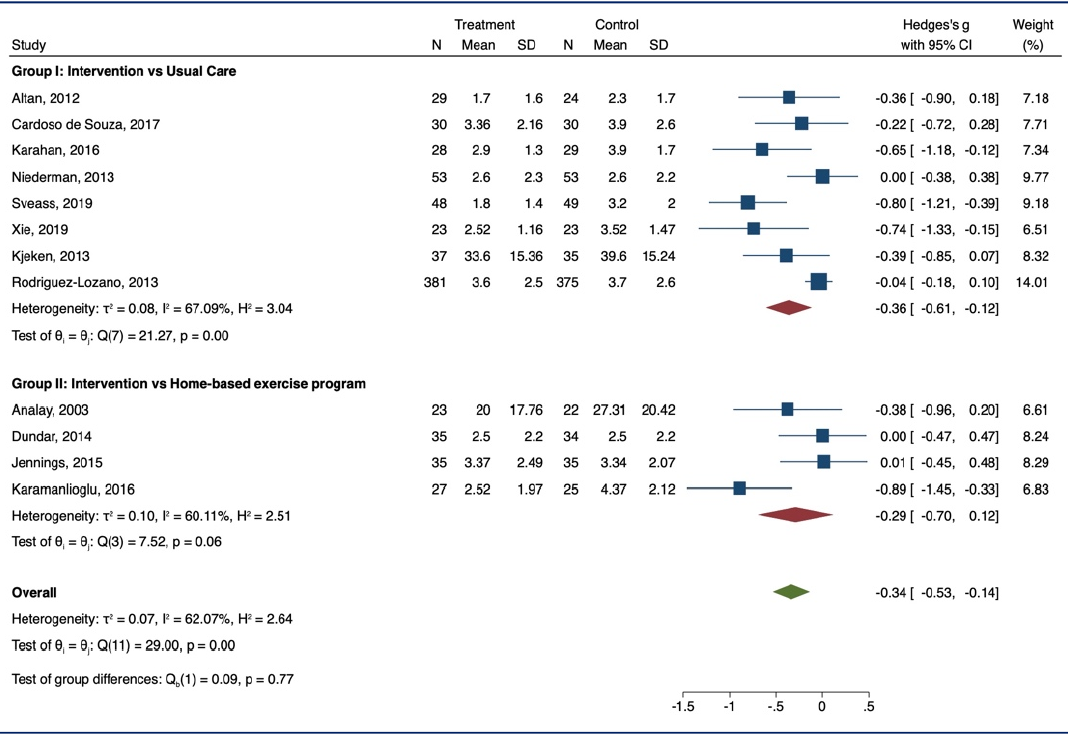
Figure 5. BASFI—Forest Plot.